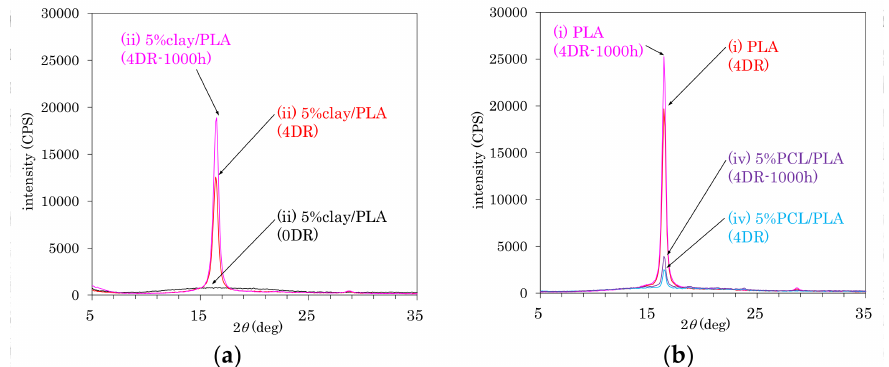
Figure 1. XRD diffraction patterns: ( a ) (ii) 5% clay/PLA; ( b ) (i) PLA and (iv) 5% PCL/PLA.